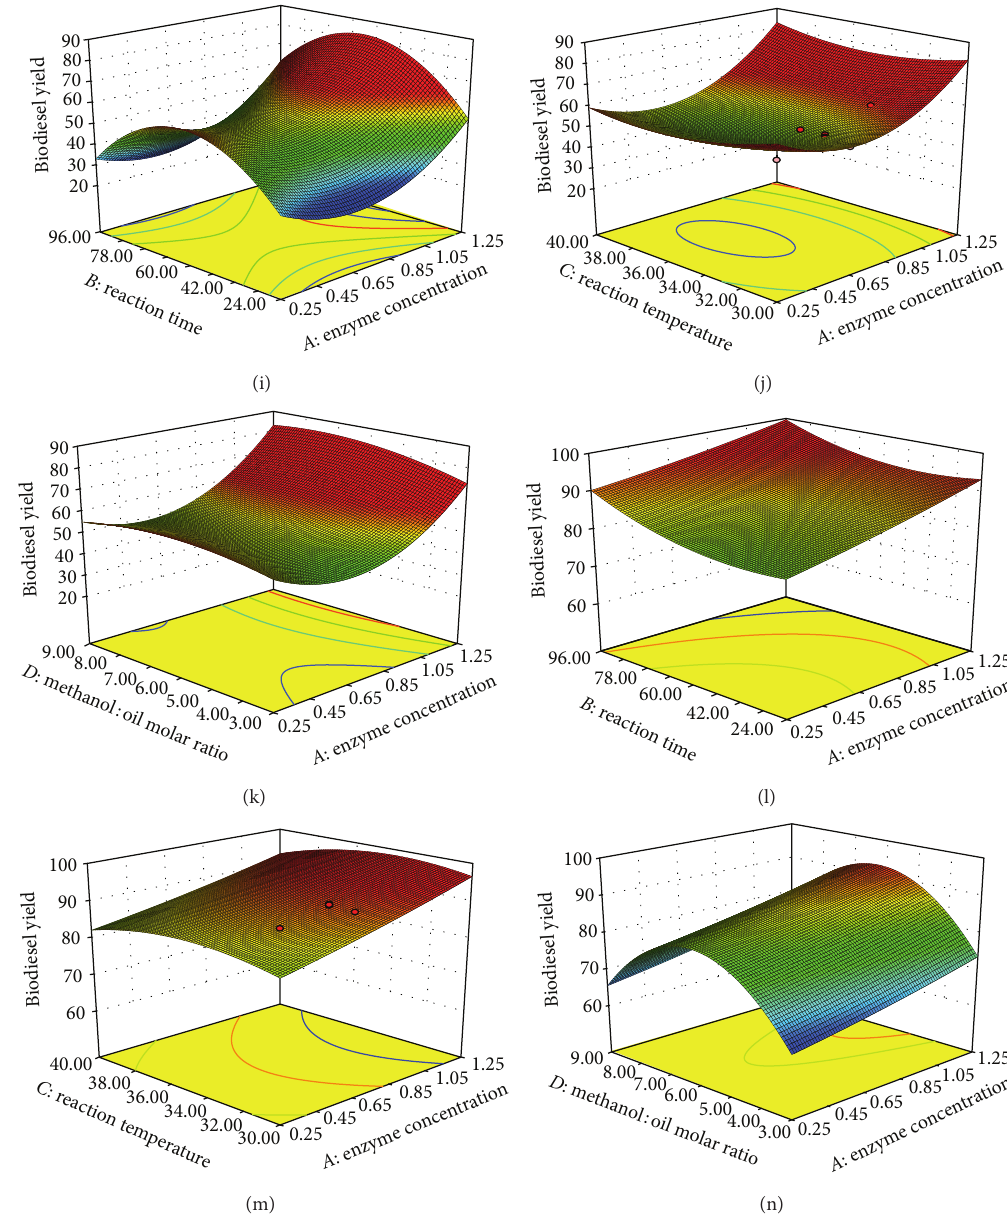
Figure 4: Response surface plots (a)–(h) showing significant first order interactions among different reaction parameters involved in palm oil biodiesel production via base catalyzed transesterification and response surface plots (i)–(n) showing significant first order interactions among different reaction parameters involved in palm oil biodiesel production via enzyme catalyzed